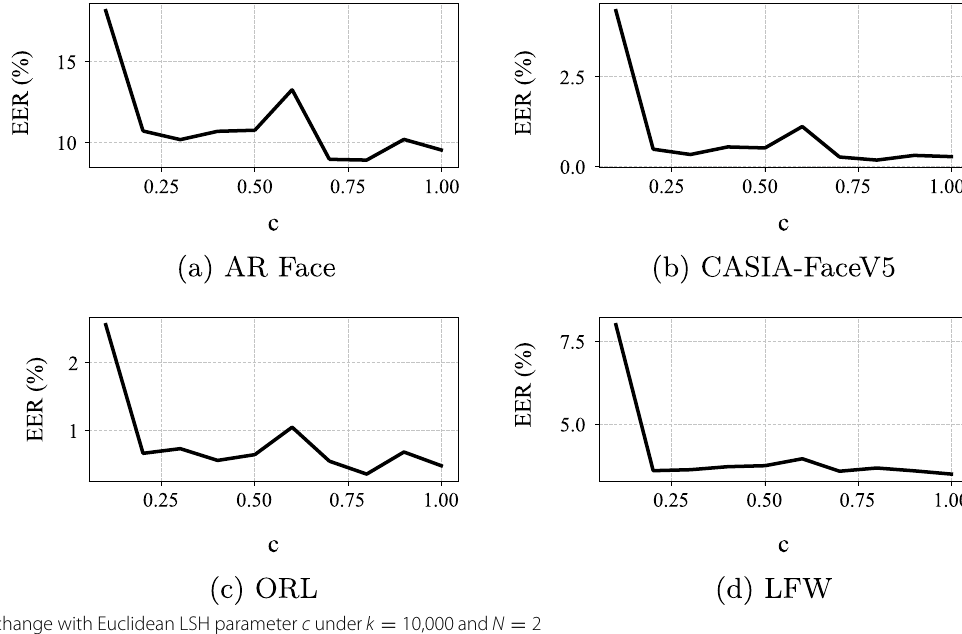
Fig. 5 EER change with Euclidean LSH parameter c under k = 10,000 and N = 2